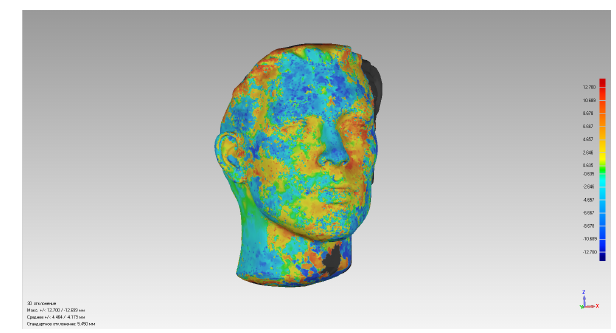
Figure 7. Evaluation result for the Head statue for images from MSVIR dataset.